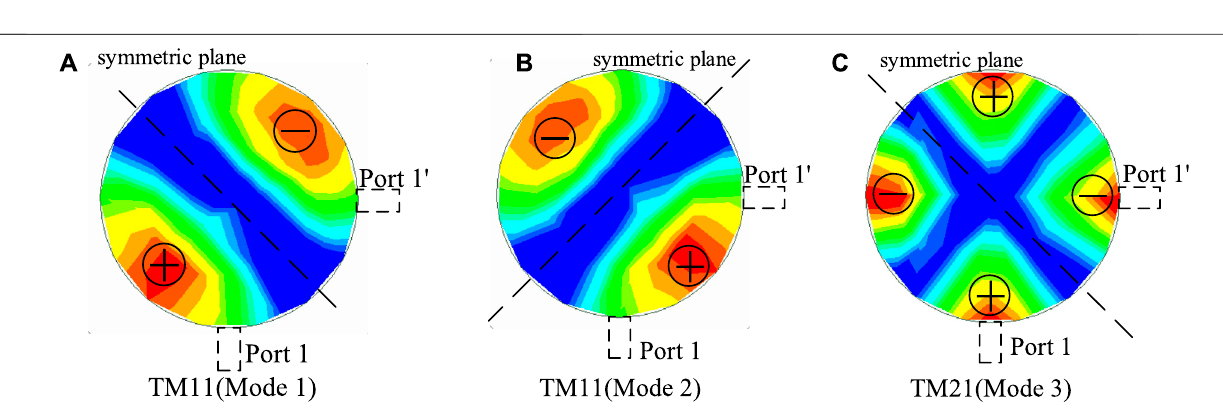
FIGURE 2 | Simulated E- fi elds of the resonant modes in the circular patch. (A) TM 11 mode (Mode 1), (B) TM 11 mode (Mode 2), and (C) TM 21 mode (Mode